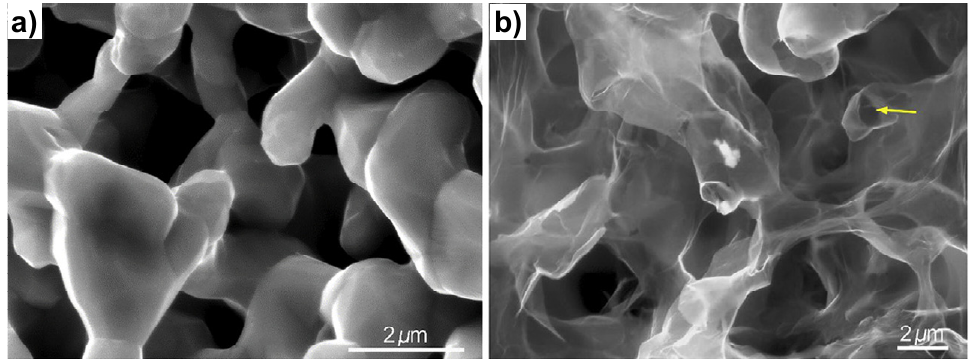
Figure 6. SEM images of ( a ) graphene-coated micron-porous Ni foam template; ( b ) micron-porous graphene foam after etching porous Ni template with the yellow arrow indicating the tubular shape of the pore. Reprinted from ref. [24] with permission from Elsevier.